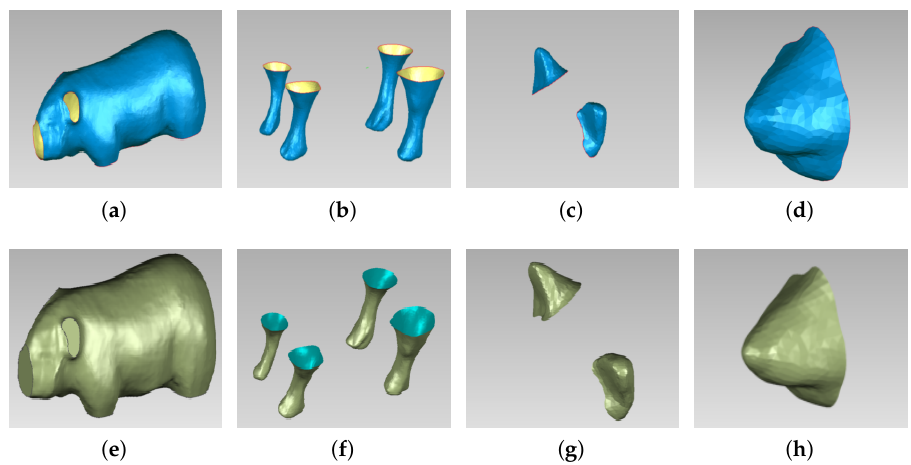
Figure 4. Polygon mesh model and surface model of different parts: ( a ) Polygon mesh model of pig body; ( b ) polygon mesh model of pig legs; ( c ) polygon mesh model of pig ears; ( d ) polygon mesh model of pig head; ( e )surface model of pig ears; ( f ) surface model of pig legs; ( g ) surface model of pig ears; ( h ) surface model of pig head.